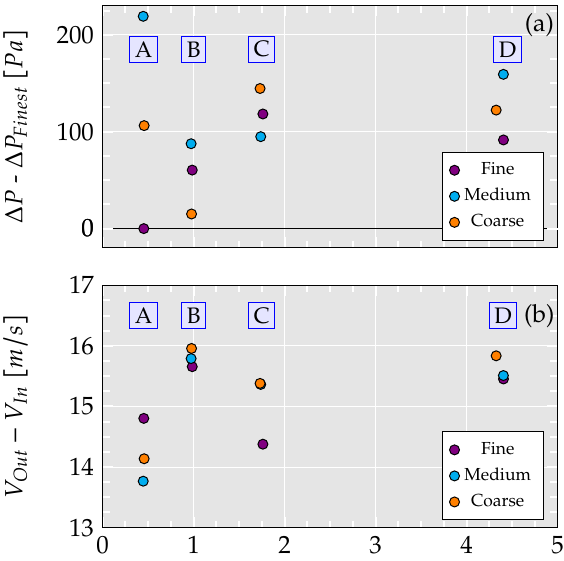
Figure 4. (a) difference of pressure loss in respect to the finest mesh vs. y + ; (b) flow acceleration vs. y + ; Figure 4. ( a ) The difference of pressure loss with respect to the finest mesh vs. y + ; ( b ) flow acceleration prism layer cells: A = 19; B = 15; C = 12; D = 8. vs. y + ; prism layer cells: A = 19; B = 15; C = 12; D = 8.